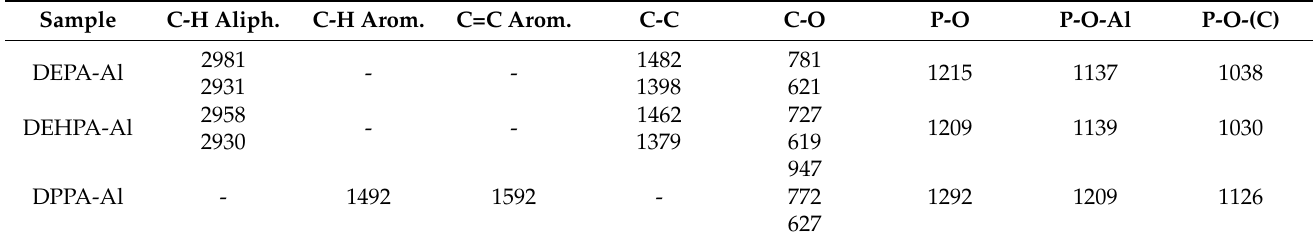
Table 3. Characteristic bands of ATR-FT/IR spectra of hybrids [cm − 1